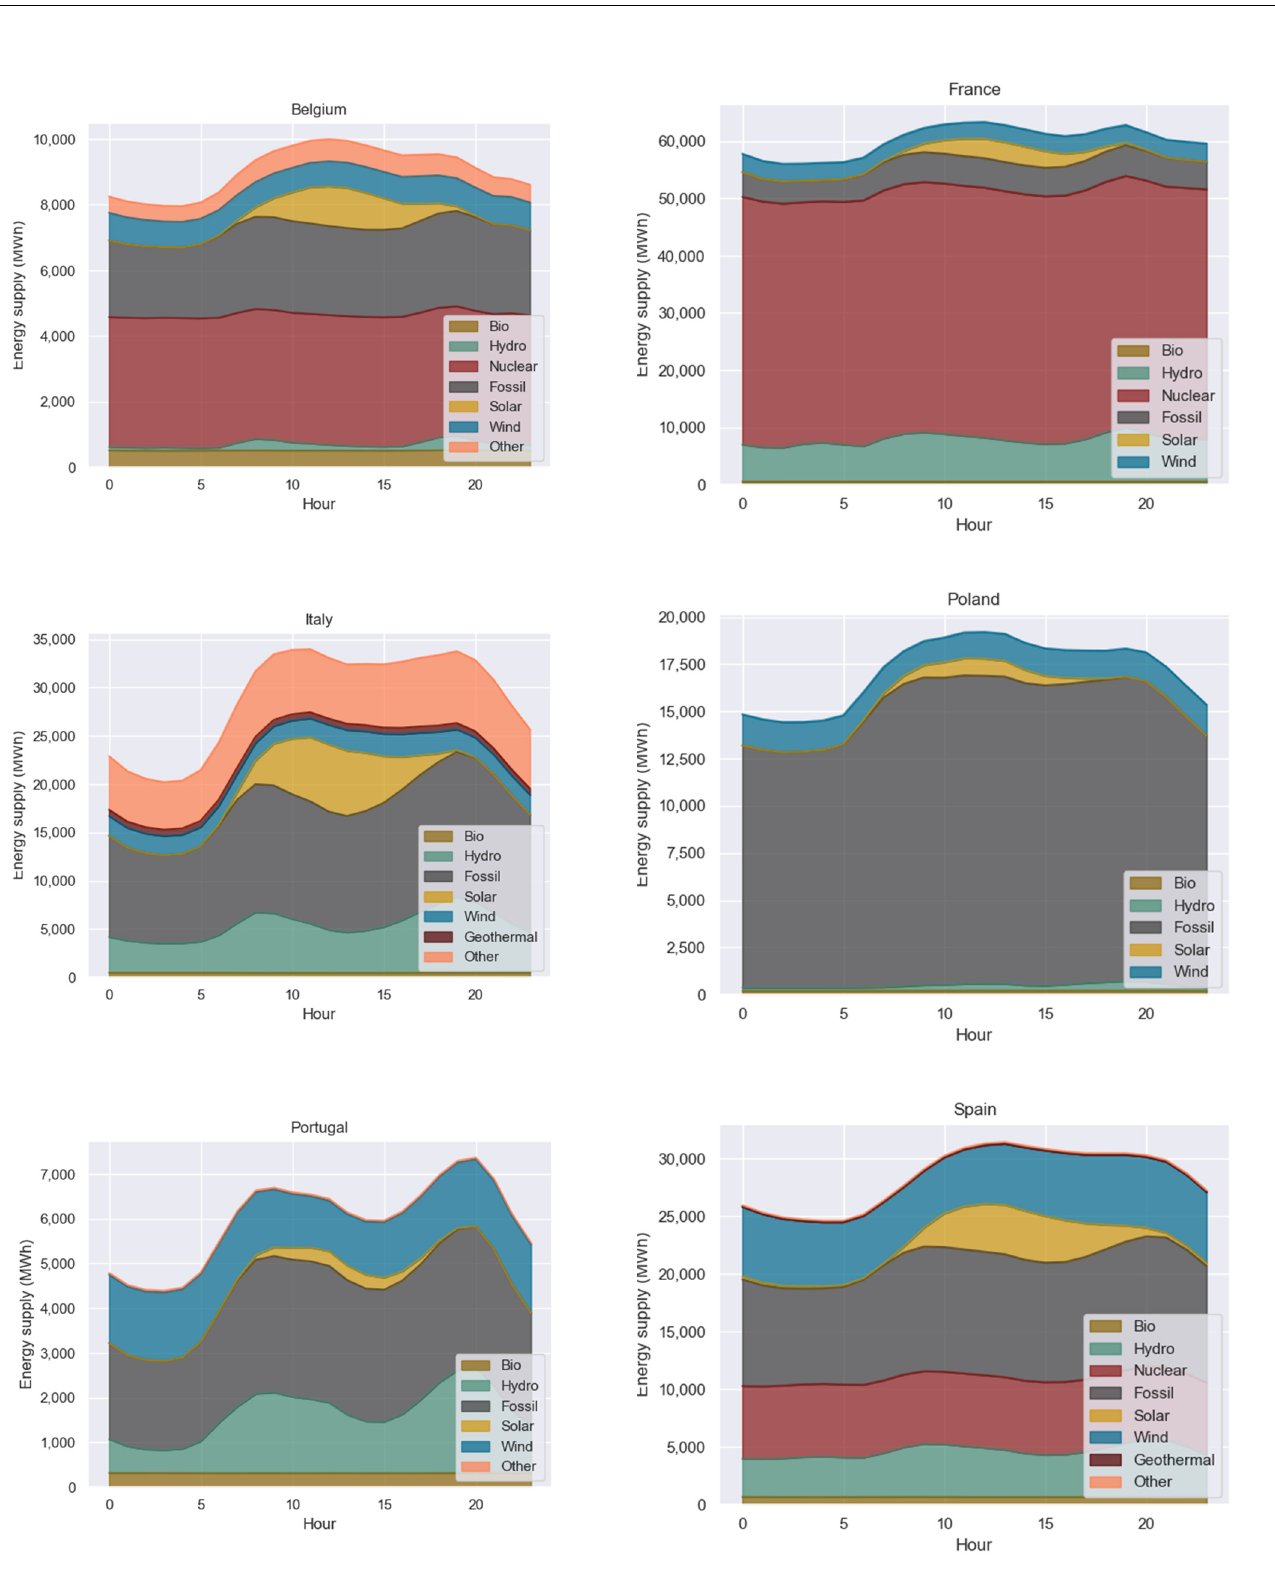
Figure 3. The energy generation mix per market. The y-axis shows the average energy supplied by each source on each reference hour.